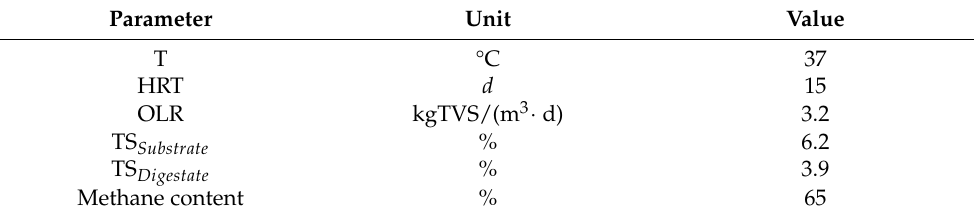
Table 1. Operating parameters of the